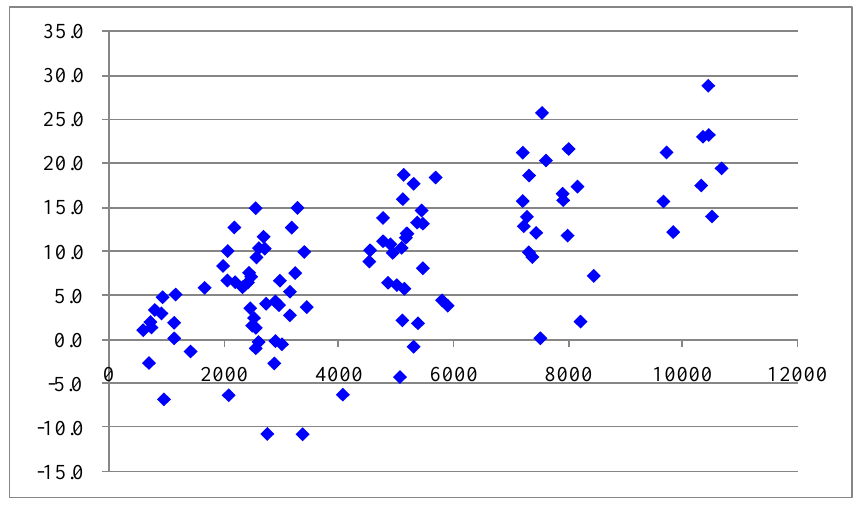
Figure 10. Length measurement